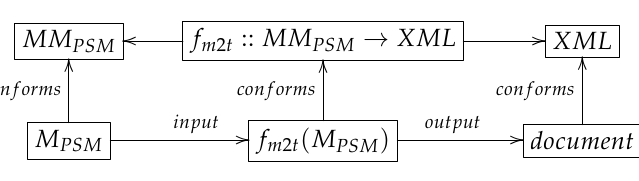
Figure 2. Traditional model-to-text transformation process.